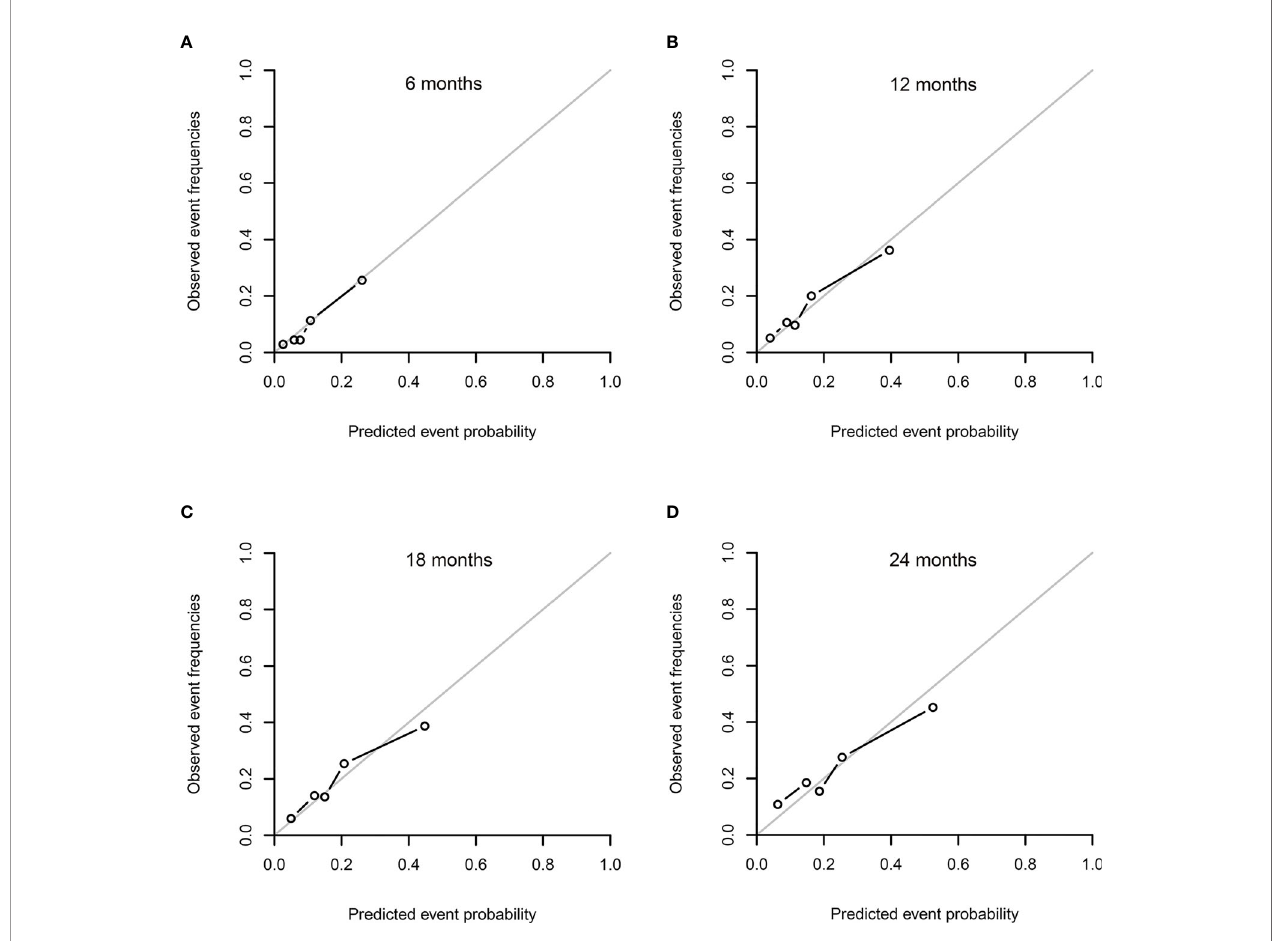
FIGURE 3 | Calibration plots for the cumulative incidence of relapse (CIR) in the internal validation at 6 (A) , 12 (B) , 18 (C) , and 24 (D) months after allogeneic hematopoietic stem cell transplantation (allo-HSCT). The calibration curves were plotted for the internal validation using a bootstrapping method with 1,000 resamples. (The gray line represents perfect equality between the observed and predicted probabilities. The closer to the gray line, the more excellent agreement was revealed between the probabilities of prediction and actual